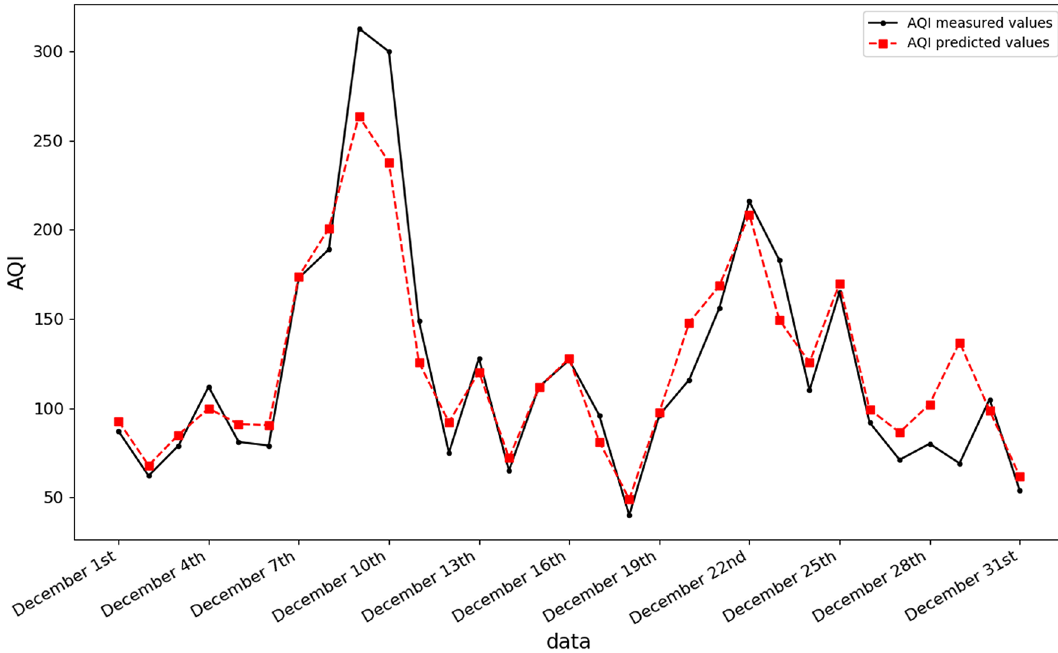
Figure 6. Comparison of modelled and measured AQI values.